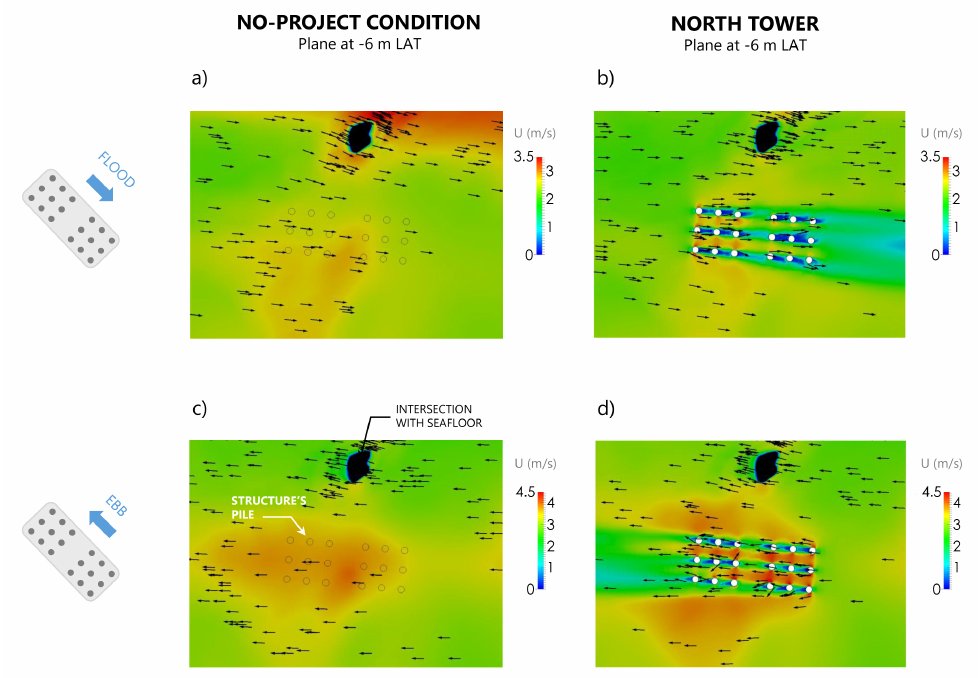
Figure 6. Velocity fields at − 6 m LAT in the North Tower site for the flood-tide scenario in the ( a ) no-project condition and ( b ), with the future assemble of 18 piles. Similar results for the ebb-tide scenario in the ( c ) no-project condition and ( d ) with the piles’ structure. Arrows show the local flow direction, black circles the location of each pile and black regions represent seafloor located above − 6 m